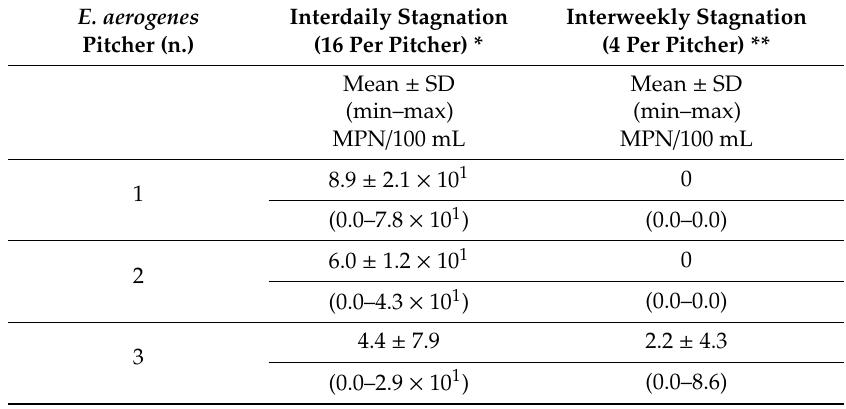
Table 1. E. aerogenes concentrations from interdaily and interweekly stagnation water (9 pitchers tested for 4